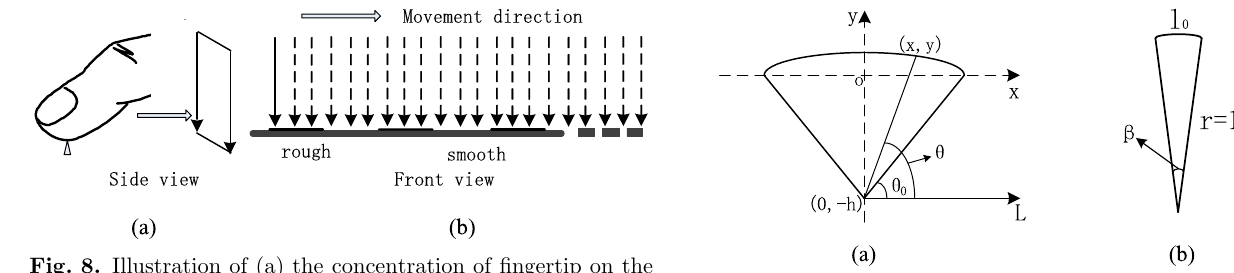
Fig. 9. (a) Virtual shape in the polar coordinate system. (b) One of the sectors whose arc length is the sliding distance corresponding to the half spatial period of the texture. ( o , -h ) is the center coordinate, ( x , y ) is the contact point, u 0 is the angle between the edge of the sector and the horizontal direction, u is the angle corresponding to the boundary between rough and smooth, r is the radius, C is the curvature, b is the half spatial period of texture, and l 0 is the arc and radius 1/ c is shown in The sector with arc length l 0 Figure 9b. According to the relation between the arc length and angle, we can obtain.